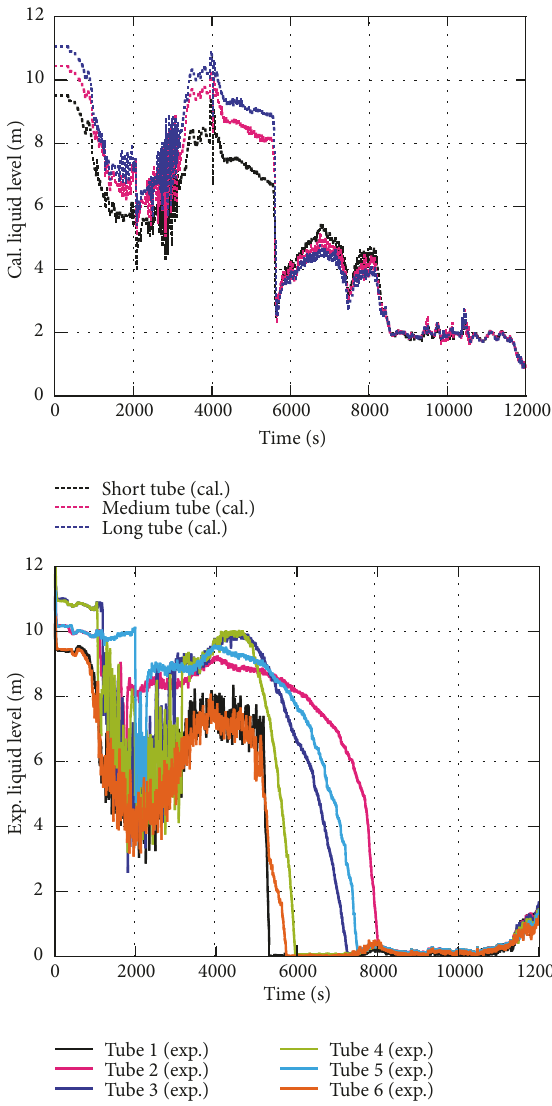
Figure 18: TR-LF-17testand RELAP5 results for SG U-tubeupflow- side collapsed liquid level in loop